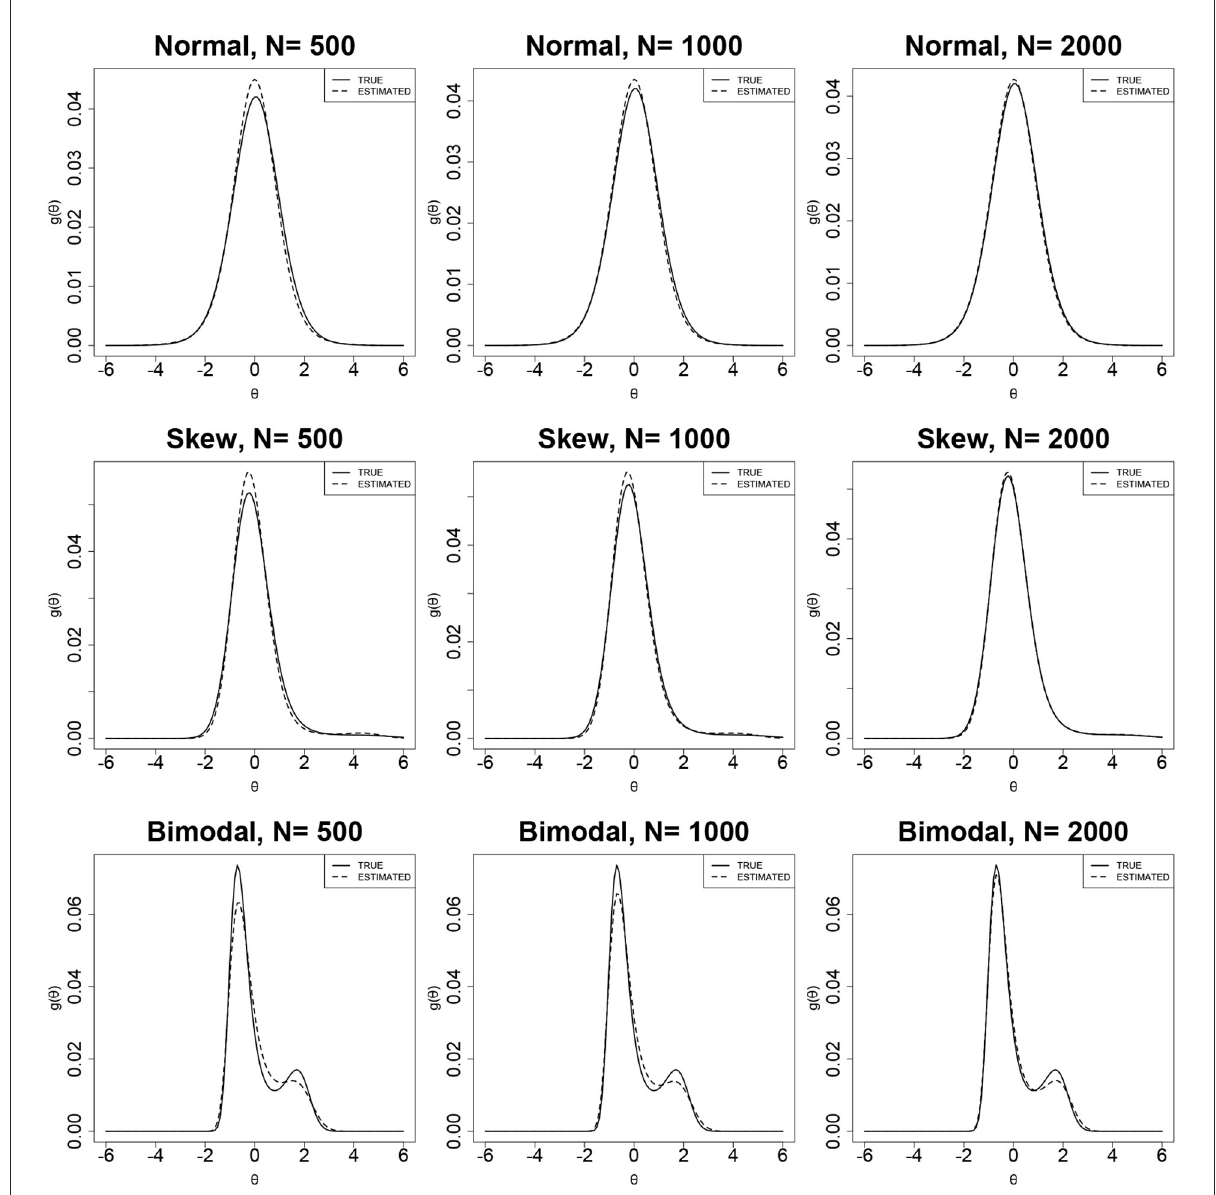
FIGURE5 True and estimated density curves using the RC-SAEM algorithm when test length is 15.